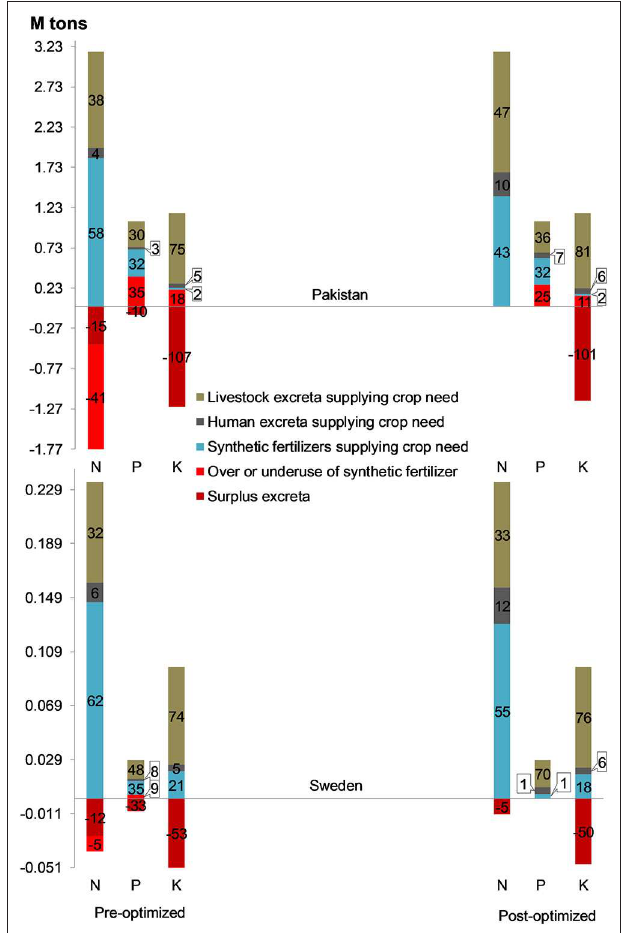
FIGURE 5 | National nutrient balances associated with scenarios of pre- and post-optimized transport of surplus excreta at decimal degree resolution in Pakistan (top panel) and Sweden (bottom panel). The height of each bar above zero represents total crop nutrient need, while the height below zero represents the total nutrient surplus given the assumptions presented in section Economic Analysis. Colors represent the nutrient source used to fill the crop nutrient need above zero while colors below zero represent the type of nutrient surplus. A gap between crop nutrient need and supply is designated as red above 0. The numbers in each colored column section represent the percentage of crop need that a source fulfills, where negative numbers (below the zero line) represent the surplus also expressed as a percentage of crop need.